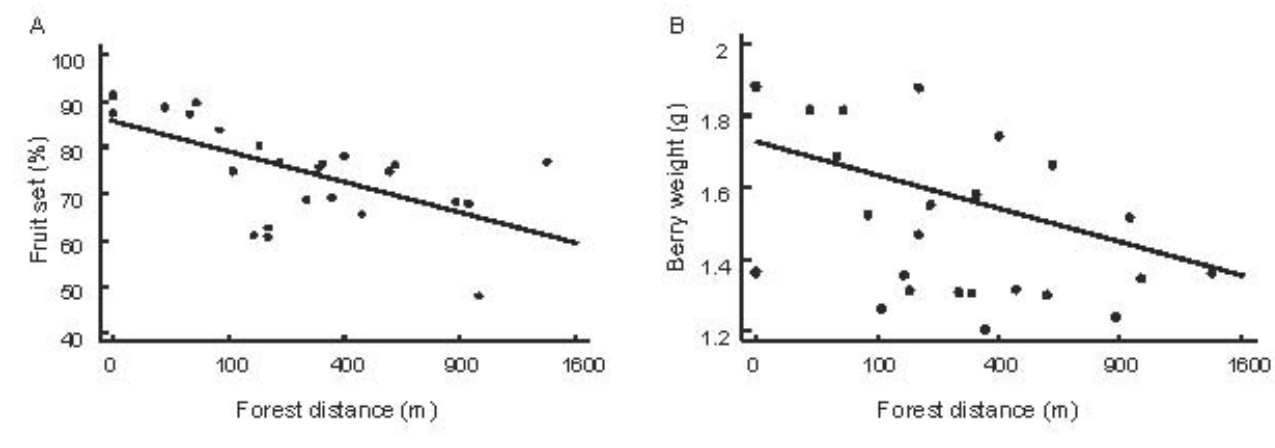
Fig. 1. Coffee fruit set and berry weight in relation to forest distance. (A) Mean fruit set of coffee plants in each of 24 agroforestry systems in relation to the distance to continuous forest (y = 85.22 – 0.64x 0.5 ; F = 11.83, R = –0.59, N = 24, P = 0.0023). (B) Mean coffee berry weight of 50 randomly sampled ripe coffee berries from each of 24 agroforestry systems in relation to the distance to continuous forest (y = 1.65 – 0.01x 0.5 ; F = 4.70, R = –0.42, N = 24, P =